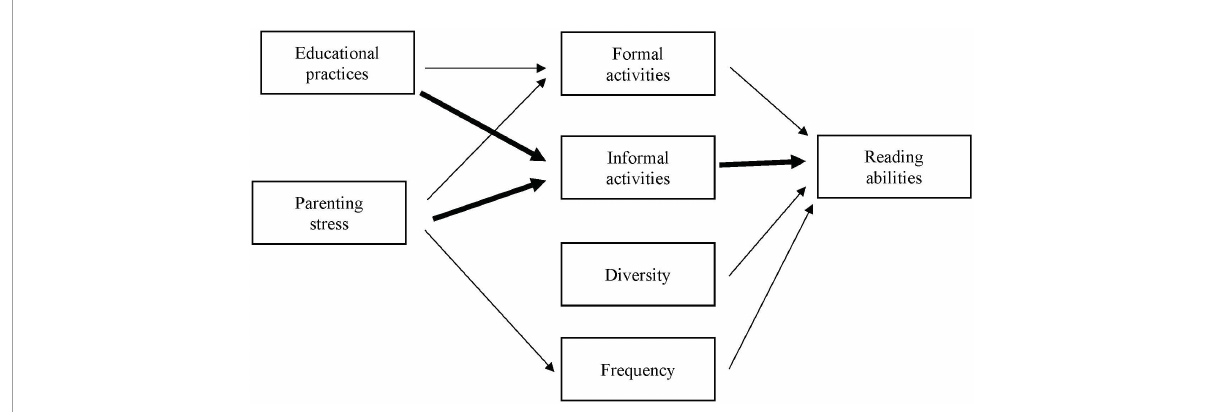
FIGURE1 Hypotheses concerning the links between reading abilities, family literacy practices and socio-familial